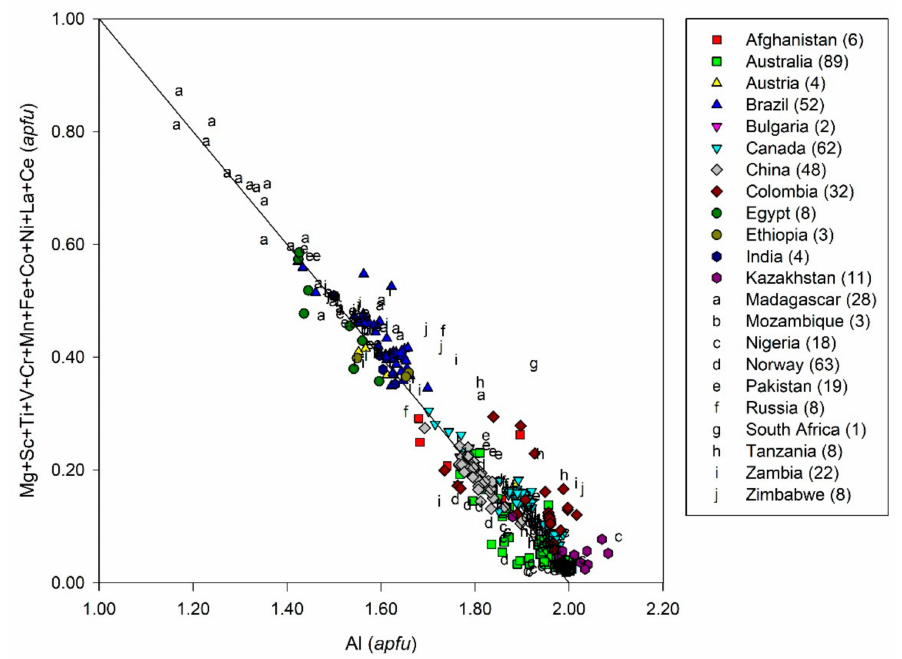
Figure 6. Al versus the sum of other Y -site cations, in atoms per formula unit, for 499 emerald analyses from the literature. The number of analyses per country is given in parentheses in the legend. Sources of data: [11–15], [16] (average of 37 analyses), [17–20], [21] (average of 88 analyses), [22] (average of approximately 130 analyses), [23–43], [44] (Kazakhstan values are averages of 11 analyses), [45] (average of 10 analyses), [46], [47] (two averages of five analyses each), [48–51], [52] (average of 55 analyses),